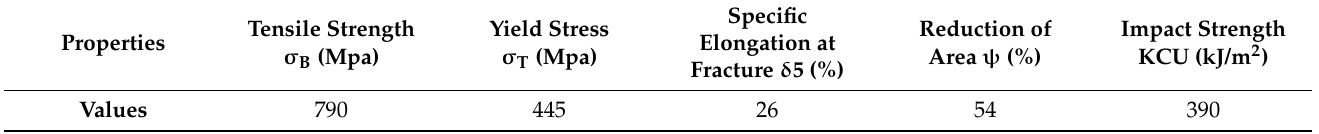
Table 2. Mechanical properties under T = 20 ◦ C of 90 CrSi